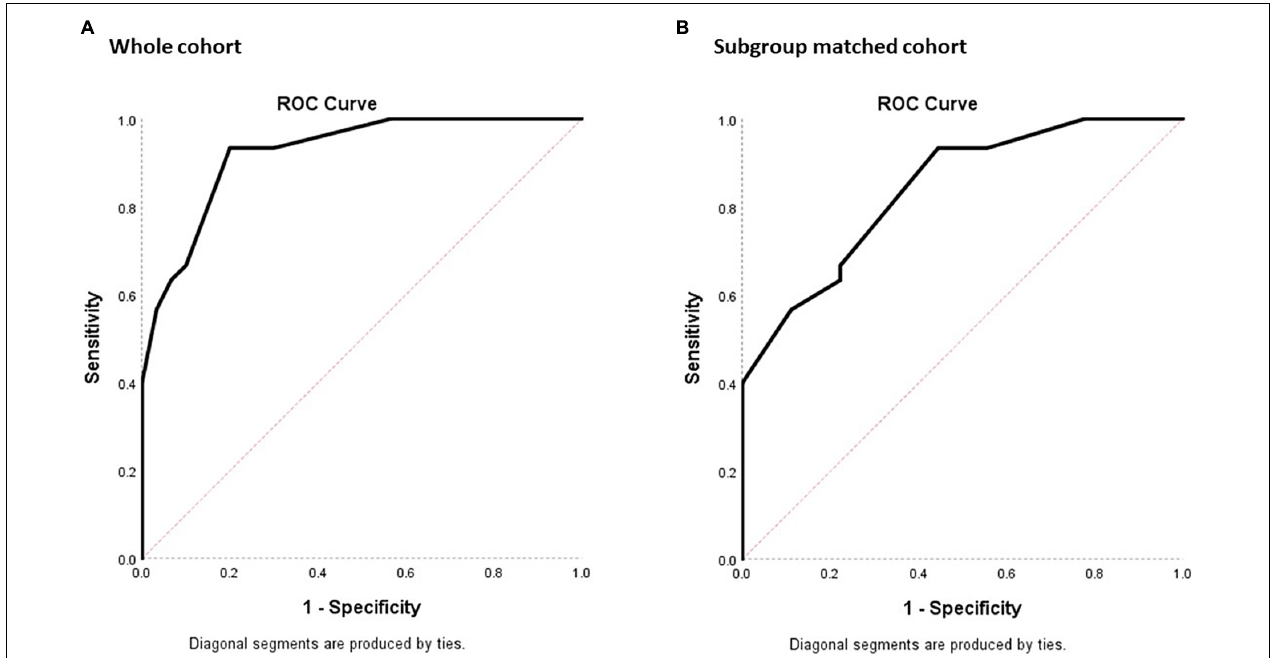
FIGURE 3 | ROC plots of sensitivity against 1- specificity for the MoCA-HA tool of the NC-HI and the MCI-HI cohort to demonstrate the screening property of the tool. (A) The 30 NC-HI and 30 MCI-HI cohorts. (B) The age/education-matched 9 NC-HI and 30 MCI-HI cohorts. (The diagonal line demonstrates no significant diagnostic property for the dichotomous outcome with sensitivity = 50% and specificity = 50%).